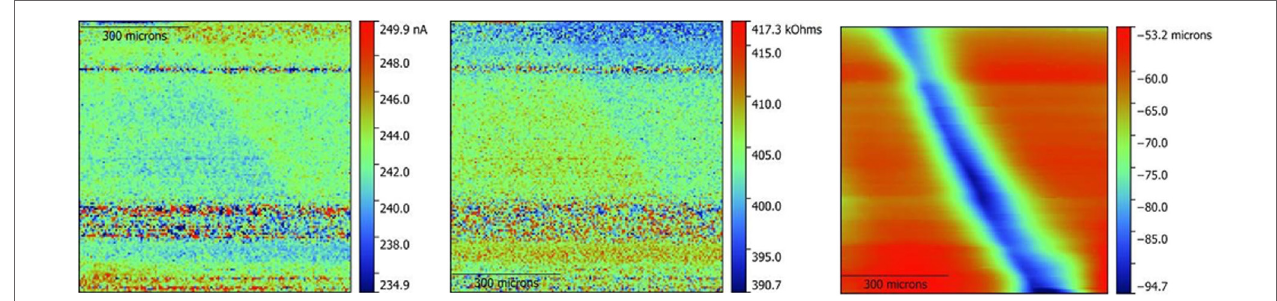
FigUre 3 | ic-ac-secM results on a scratched PTFe blank in a 0.1M TBa-clO 4 Pc solution . On the left, ac current magnitude, in the middle, impedance, and, on the right, topography. Note that the absolute scale of the impedance change is ~5% of the signal measured in Figure 4 (middle) and is dominated by noise in this